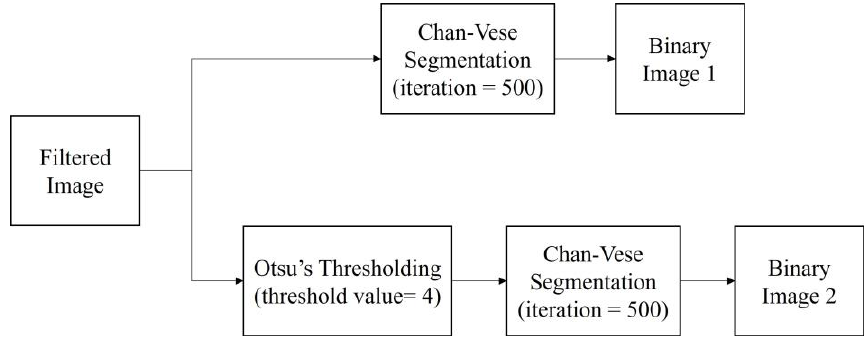
Figure 9. Segmentation methods applied in the study.